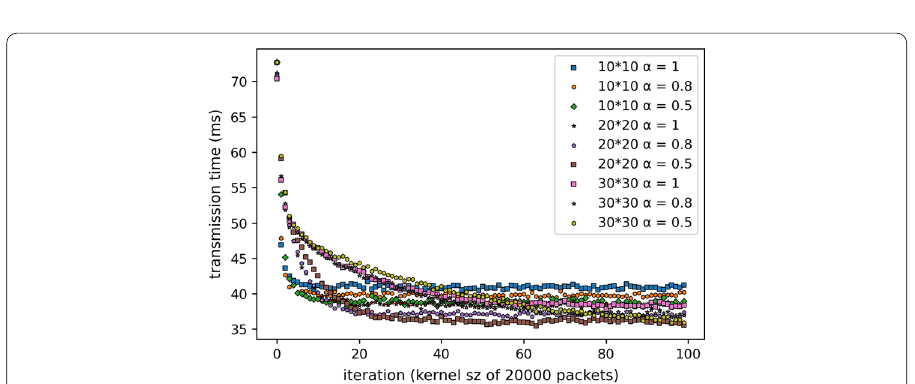
Fig. 13 Different networks with different learning